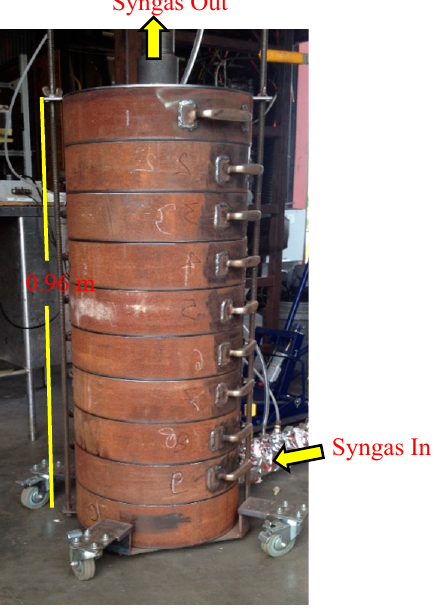
Figure 3. 10-layered biomass-based filter system.